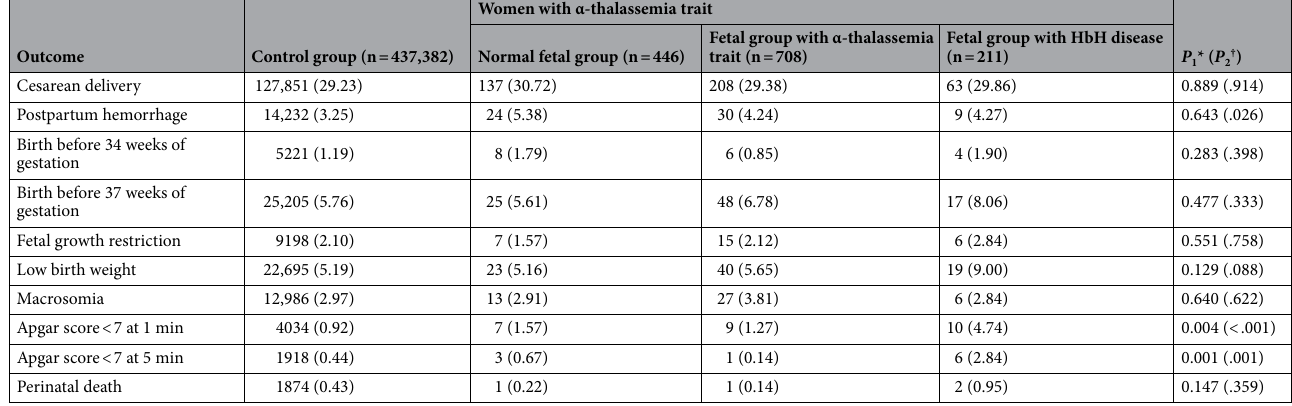
Table 2. Comparison of pregnancy outcomes among the four groups. Data are n (%) unless otherwise specified. *Chi-squared or Fisher–Freeman–Halton exact test for three subgroups. † Chi-squared or Fisher– Freeman–Halton exact test for all groups.